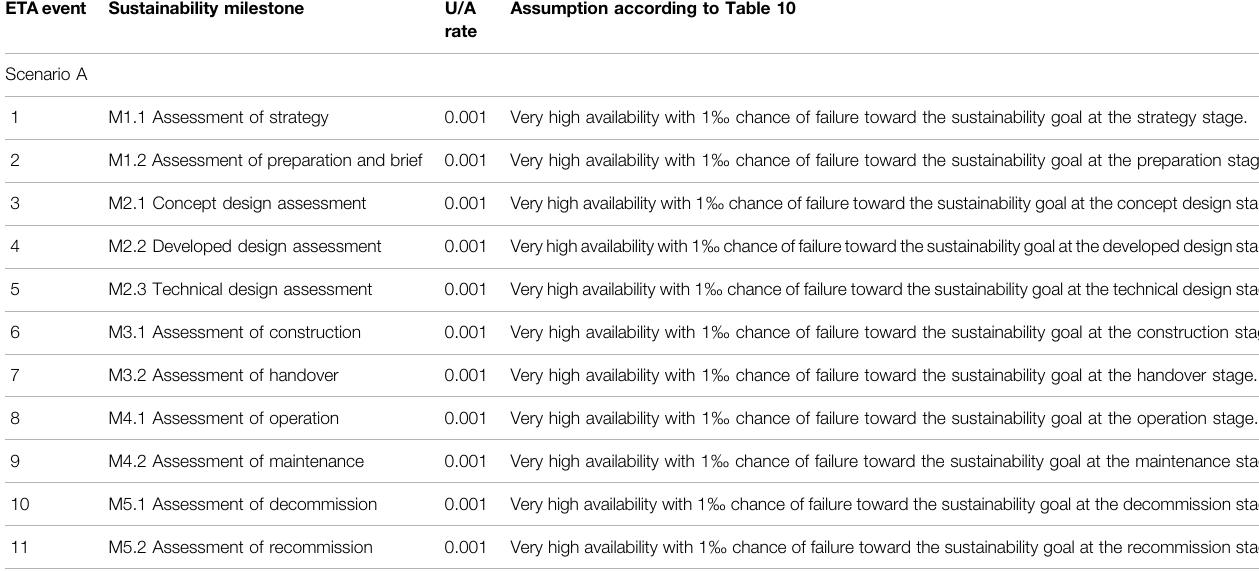
TABLE 11 | Unavailability upon megaproject sustainability in the ETA experiment: Scenario A. ETAevent Sustainability milestone U/A